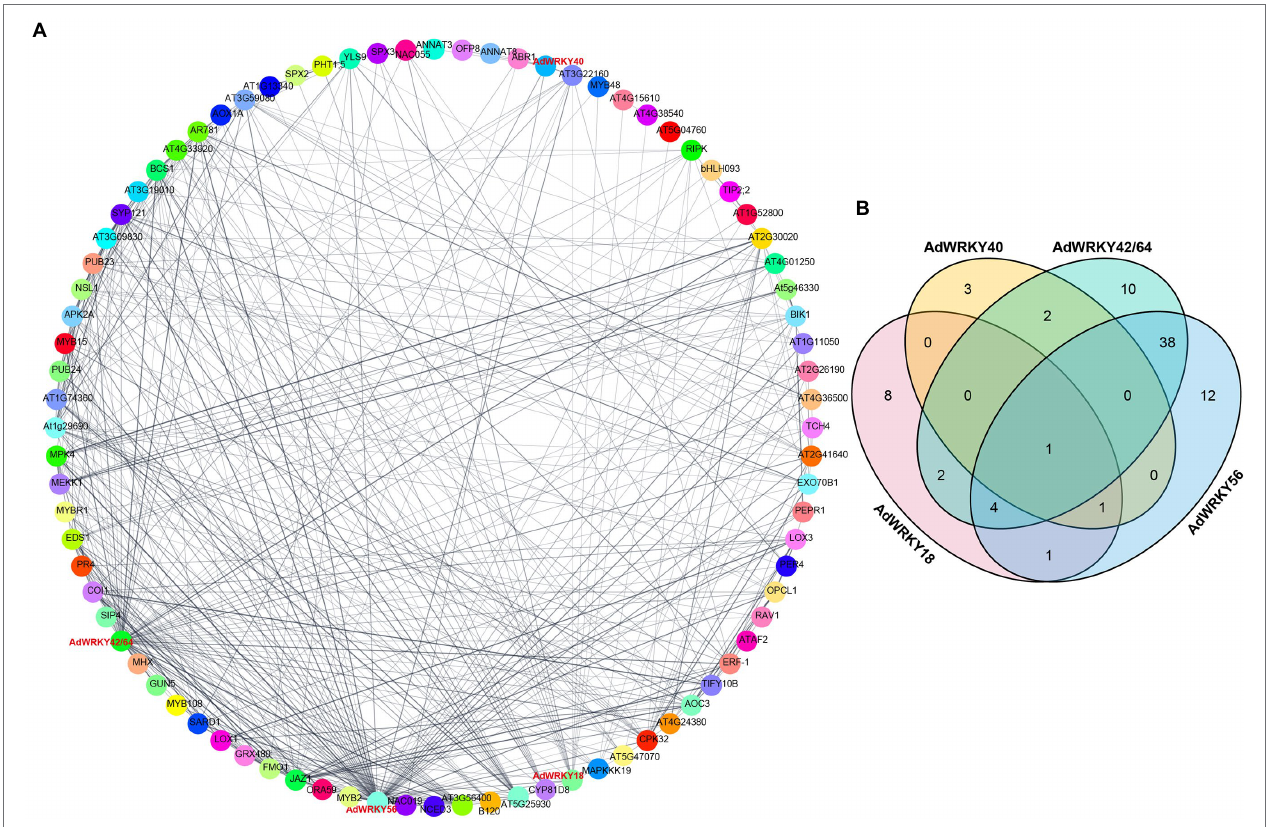
FIGURE 3 | The interaction between AdWRKYs and other proteins. (A) The interaction between AdWRKYs and other proteins. (B) The number of other proteins interacting with